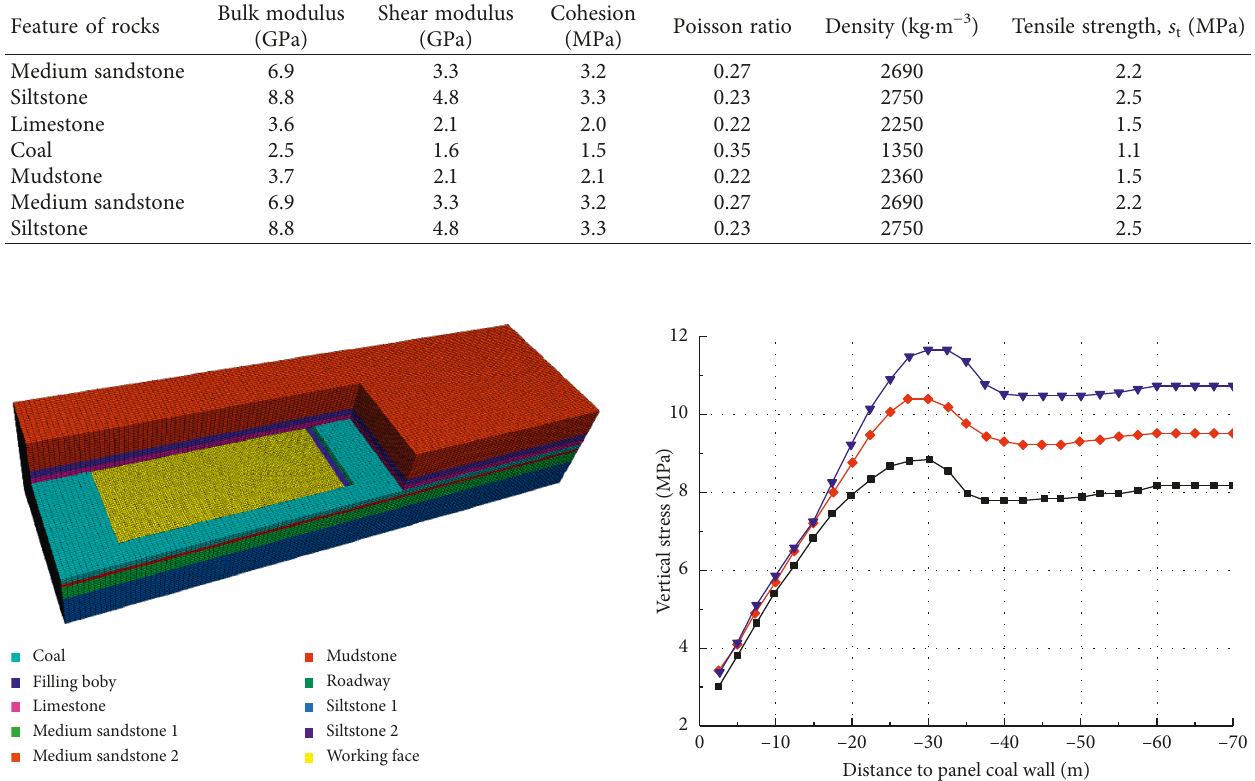
Figure 8: Diagram of the three-dimensional numerical simulation model.